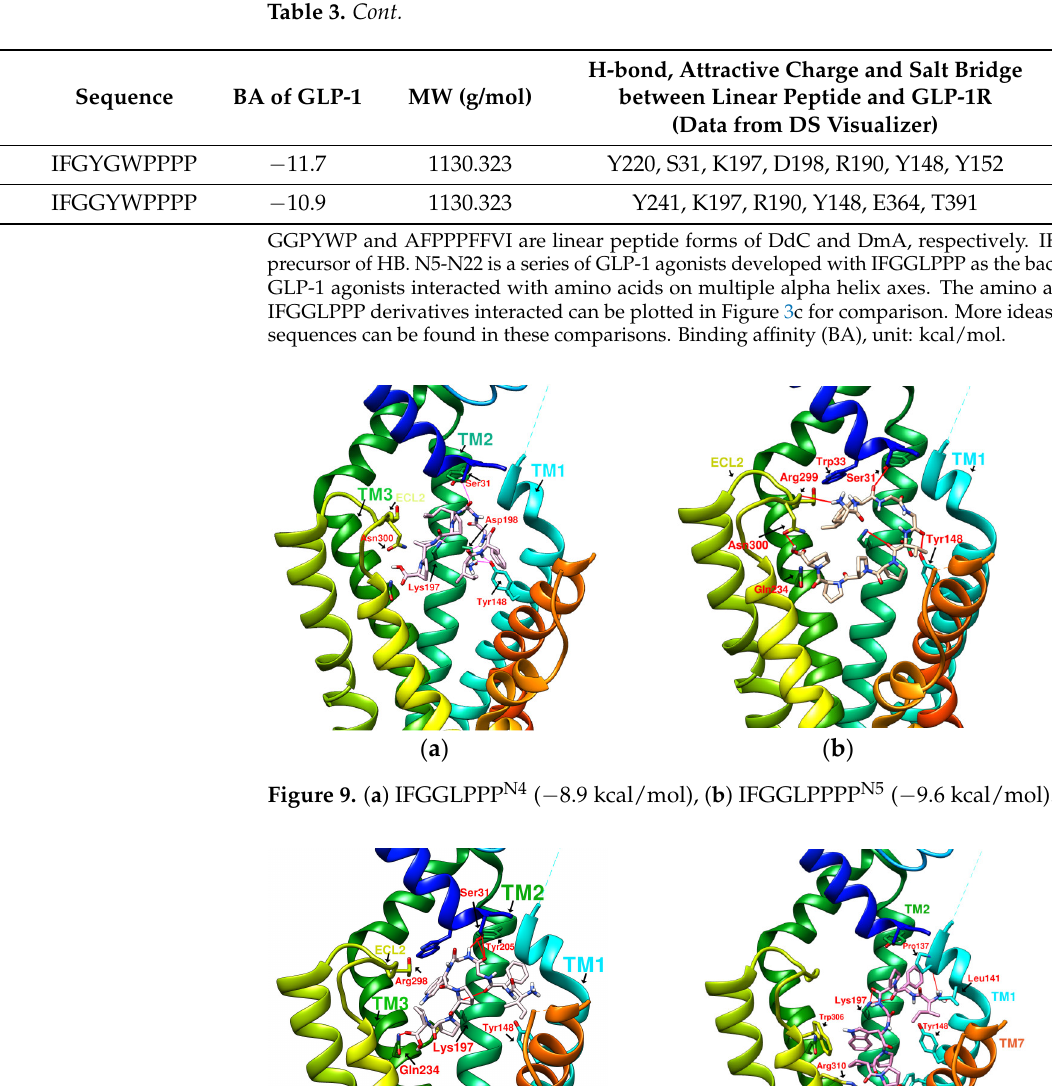
Figure 11. ( a ) IFGGYWPPP N20 (−10.9 kcal/mol), ( b ) IFGYGWPPPP N21 (−11.7 kcal/mol).